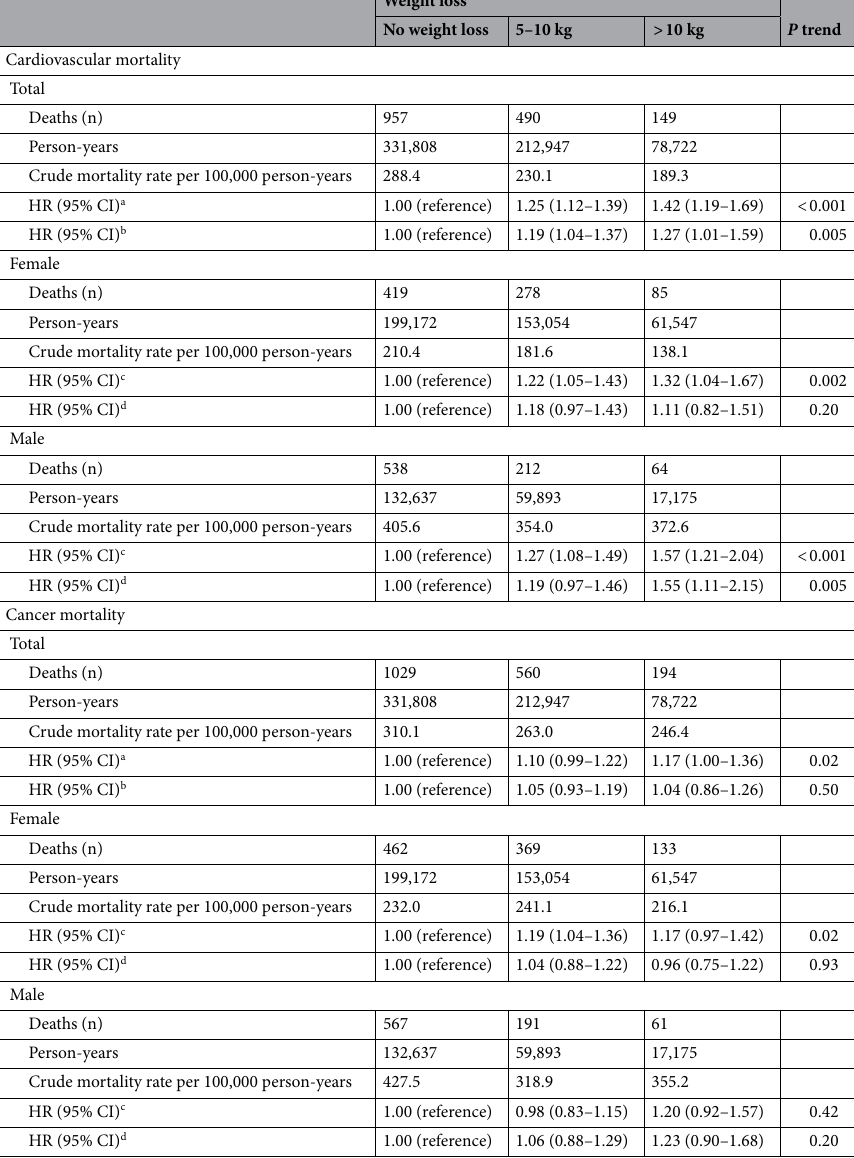
Table 3. Mortality rates and hazard ratios for the association between weight loss and cardiovascular-, and cancer mortality. HR hazard ratio, CI confidence interval. a Adjusted for age and sex at enrollment. b Adjusted for age, sex, body mass index, cigarette smoking, alcohol consumption, level of education, income, physical activity, sleep, and subjective health. c Adjusted for age at enrollment. d Adjusted for age, body mass index, cigarette smoking, alcohol consumption, level of education, income, physical activity, sleep, and subjective